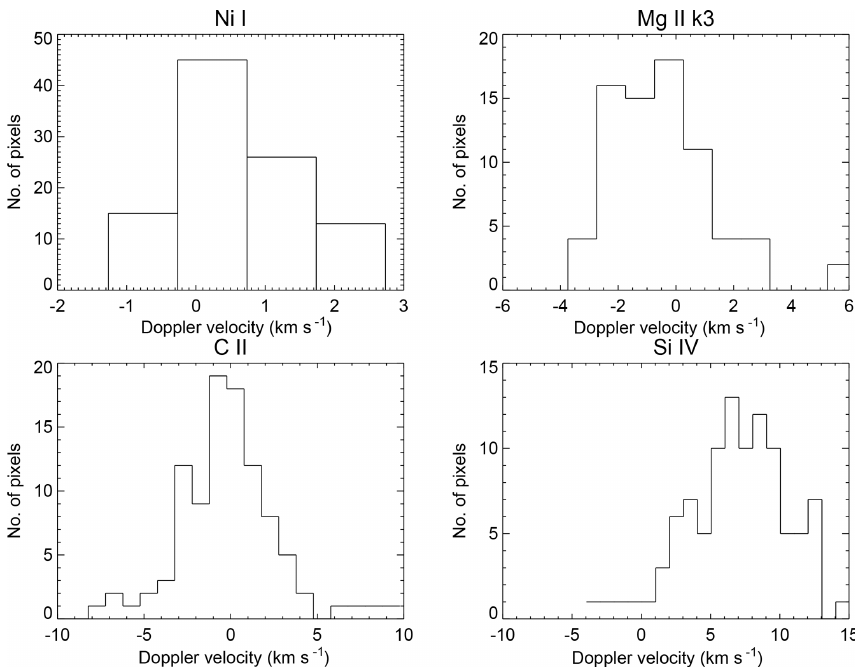
Figure 10. The velocity distributions for different spectral lines corresponding to different temperatures at box